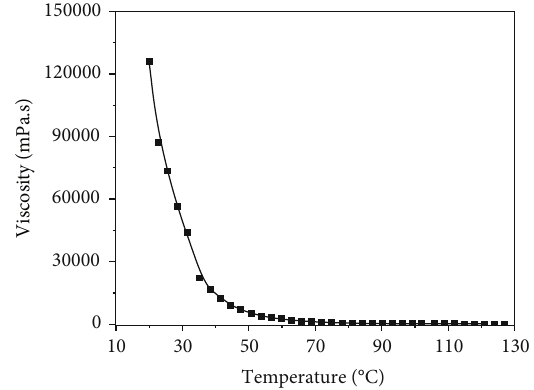
Figure 1: Viscosity-temperature